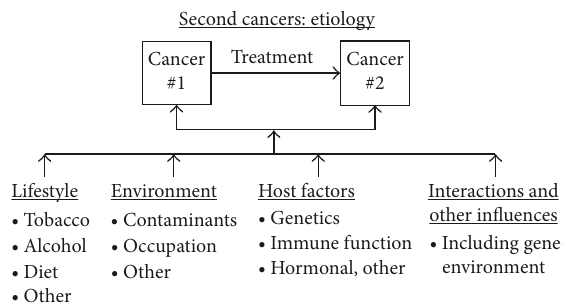
Figure 1: Risk factors for second primary cancer (refer to text). Many influences some of which are diagrammed here may con- tribute to the development of multiple primary cancers, including interactions between exposures. ∗ Adapted with permission from Travis